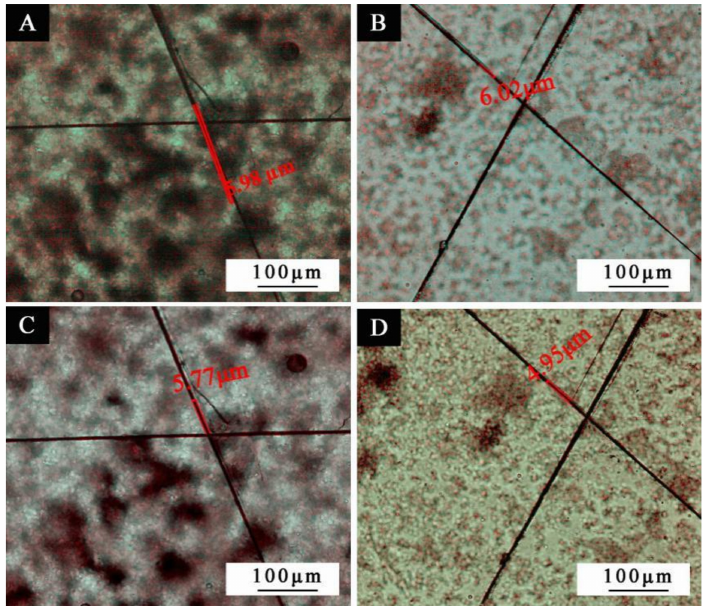
Figure 12. Optical images before and after self-repairing of the coating film with two kinds of micro- capsules: Dulux water-based emulsion microcapsules ( A ) before self-repairing, ( C ) after self-repairing; Nippon water-based emulsion microcapsules ( B ) before self-repairing, ( D ) after